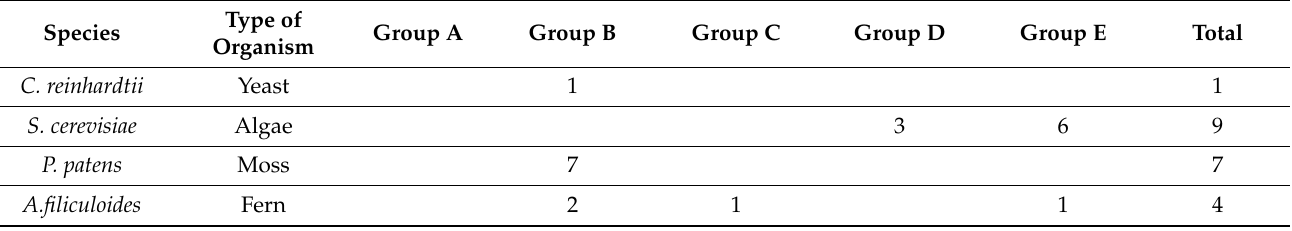
Table 1. Number and type of SPX genes in 28